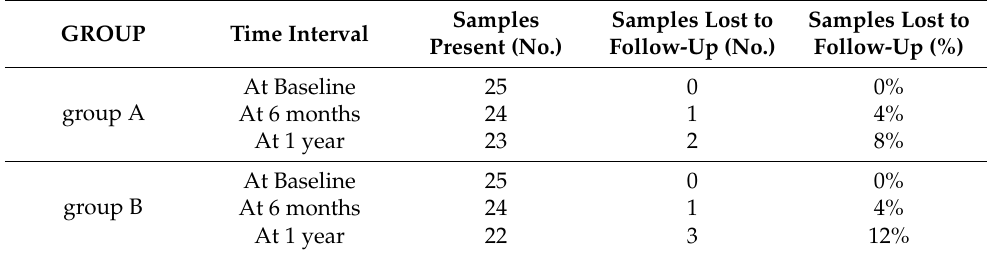
Table 2. Samples lost to follow-up in group A and B at different time intervals. GROUP Time